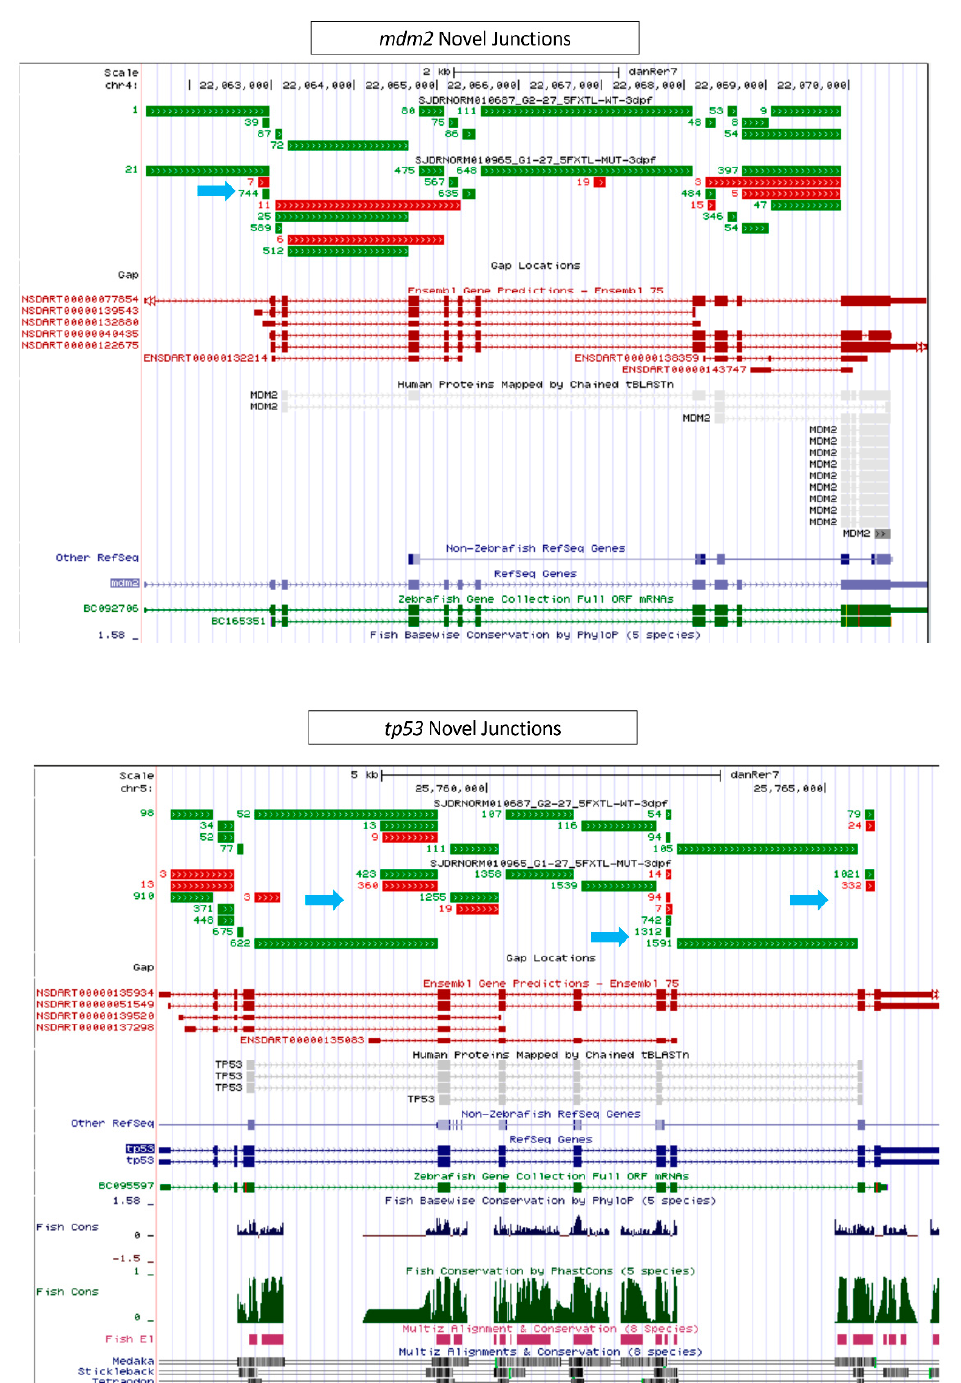
Figure 9. Novel junctions for tp53 and mdm2 in cp27.5 mutants. Top panel: Junction read counts at mdm2 locus displayed in the University of California Santa Cruz (UCSC) genome browser. Green represents known junctions and red represents novel junctions. Bottom panel: Junction read counts at tp53 locus displayed in UCSC genome browser. Green represents known junctions and red represents novel junctions.